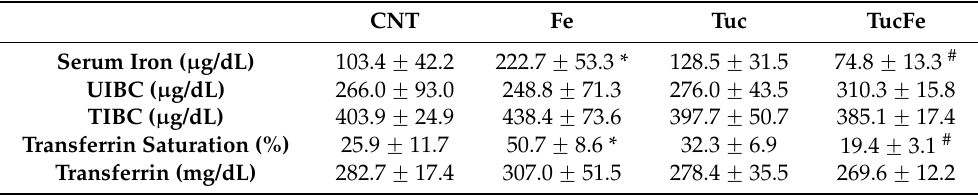
Table 2. Effects of tucum-do-cerrado ( Bactris setosa Mart.) consumption on serum iron parameters in rats treated with AIN-93G diet supplemented or not supplemented with iron for 30 days.